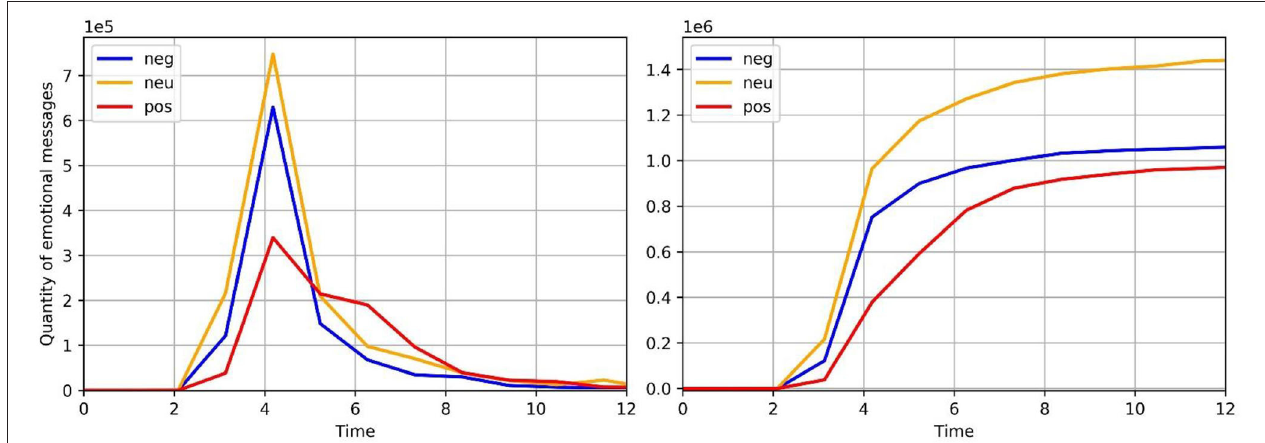
FIGURE 14 | Amount of emotional information.